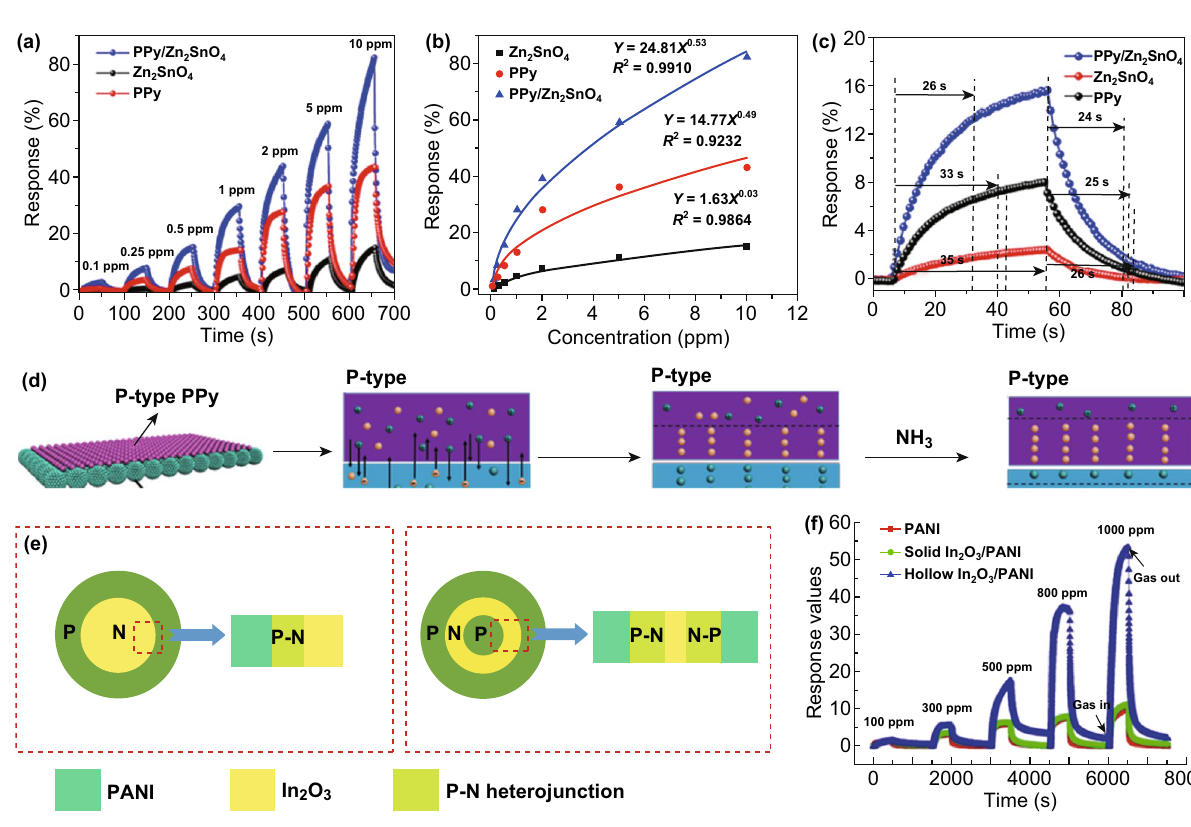
Fig. 13 a NH 3 response to PPy-Zn 2 SnO 4 , PPy, and Zn 2 SnO 4 . b Curve of concentration versus response. c Curve of a single response and recov- ery to NH 3 . d Schema of sensing mechanism. Reproduced with permission [121]. Copyright 2018, Elsevier. e Schema of sensing mechanism. f Gas response of PANI, solid In 2 O 3 /PANI and hollow In 2 O 3 /PANI. Reproduced with permission [122]. Copyright 2016, Springer